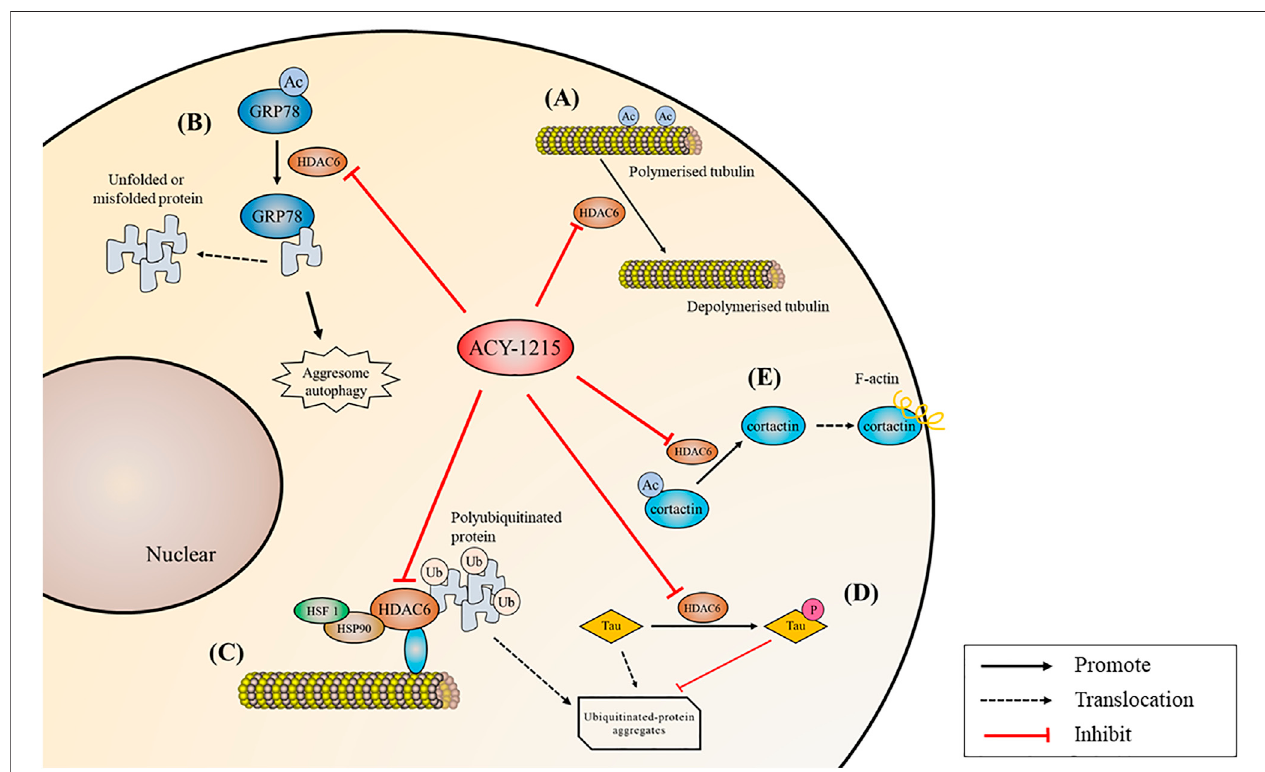
FIGURE 4 | Biological processes regulated by ACY-1215. (A) Acetylate tubulin and increase microtubule stability. (B) Acetylate GRP78, inhibit misfolded or unfolded protein in the aggregate pathway and inhibit protein degradation. (C) Acetylate HSP90 and reduce polyubiquitinated protein transportation. (D) Reduce tau hyperphosphorylation and promote clearance. (E) Reduce F-actin depended cell migration by deacetylating